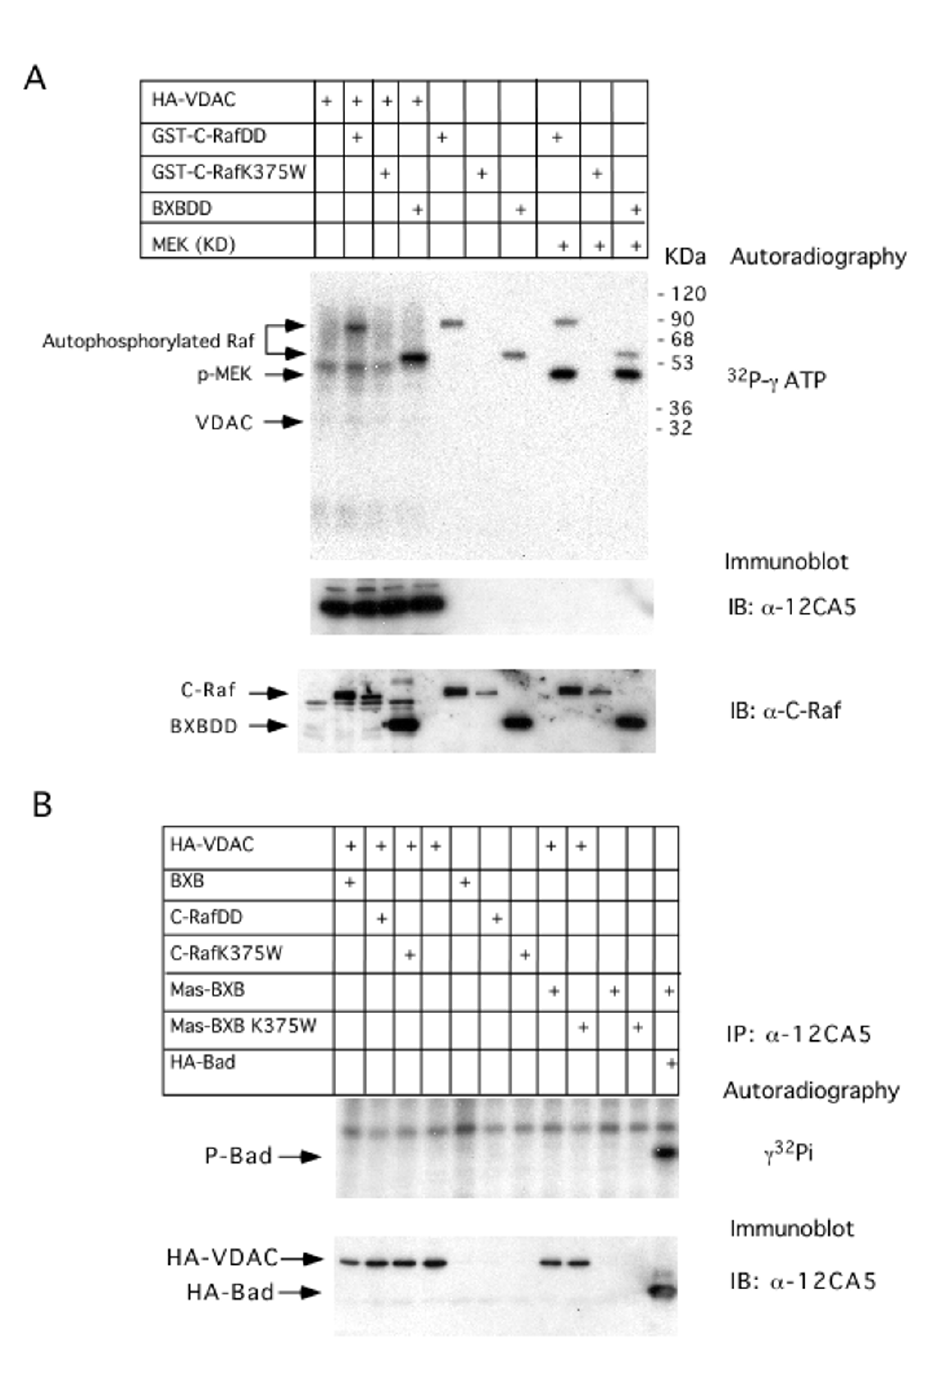
Figure 5 C-Raf kinase does not phosphorylate VDAC protein. A. In vitro kinase assay was performed using GST-C-Raf recombinant protein and HA-VDAC immunoprecipitated from 293 cells. HA-VDAC was incubated with recombinant active or inactive GST-C-Raf proteins in presence of radioactive ATP. As a positive control GST-C-Raf was incubated with MEK kinase dead substrate in the same conditions. The blots were also probed with anti-HA and anti-C-Raf antibodies. B. In vivo phospholabelling was performed by coexpressing HA-VDAC with different C-Raf constructs in 293 cells. Transfected cells were incubated with radioactive orthophosphate before HA-VDAC immunoprecipitation. HA-Bad was used as a positive